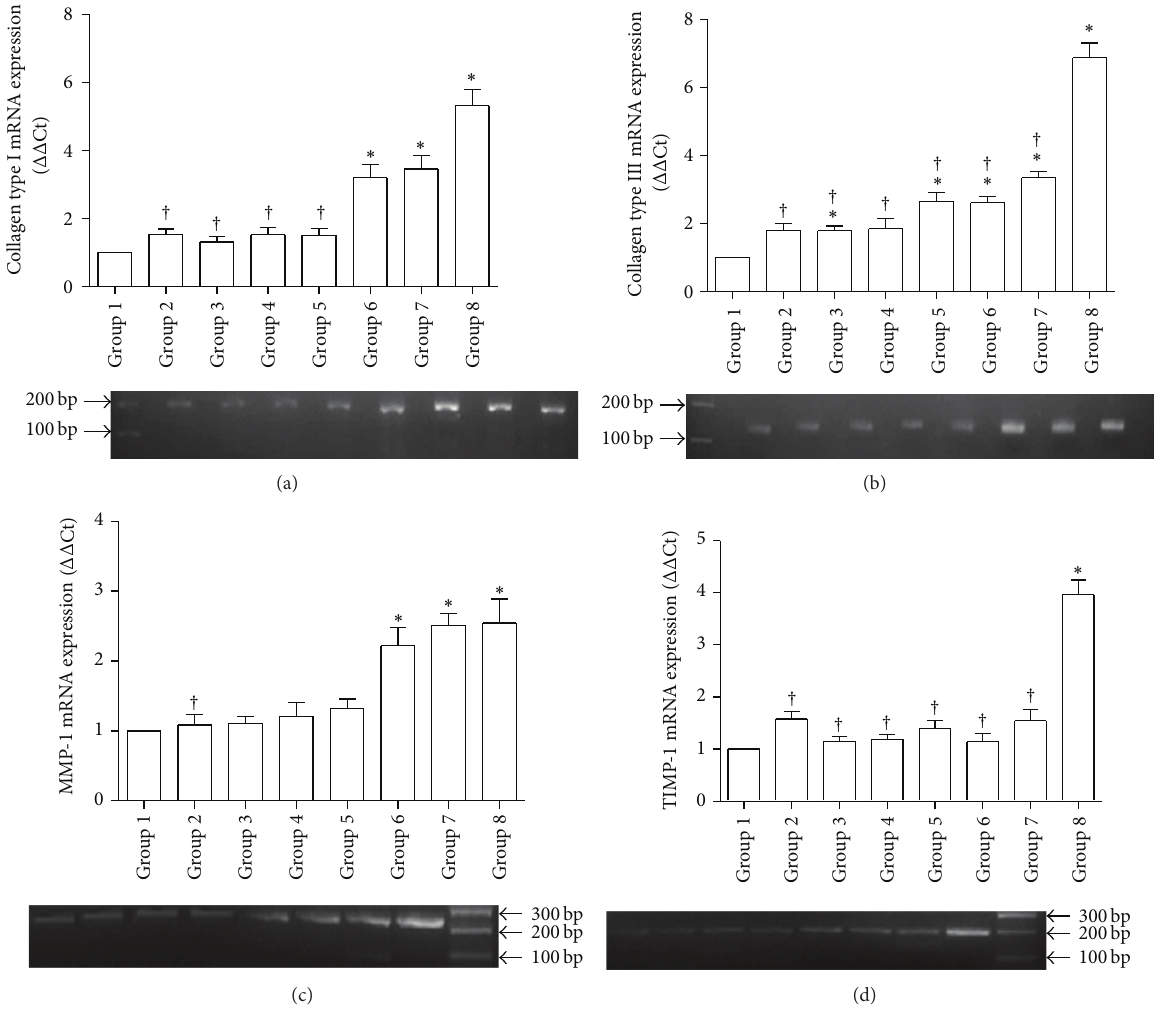
Figure 3: Measurement for collagen metabolism of D-gal induced aging skin after each treatment. Skin wound was processed and analyzed for expression of collagen type I (a), collagen type III (b), MMP-1 (c) and its inhibitor, and TIMP-1 (d) by quantitative RT-PCR. Expression levels for each targeting gene were normalized to endogenous reference gene and reported as relative values ( ΔΔ Ct) to those obtained from aging control group. ∗ and † indicate a significant difference ( 𝑃 < 0.05 ) when compared to negative control (group 1) and sham control (group 8),